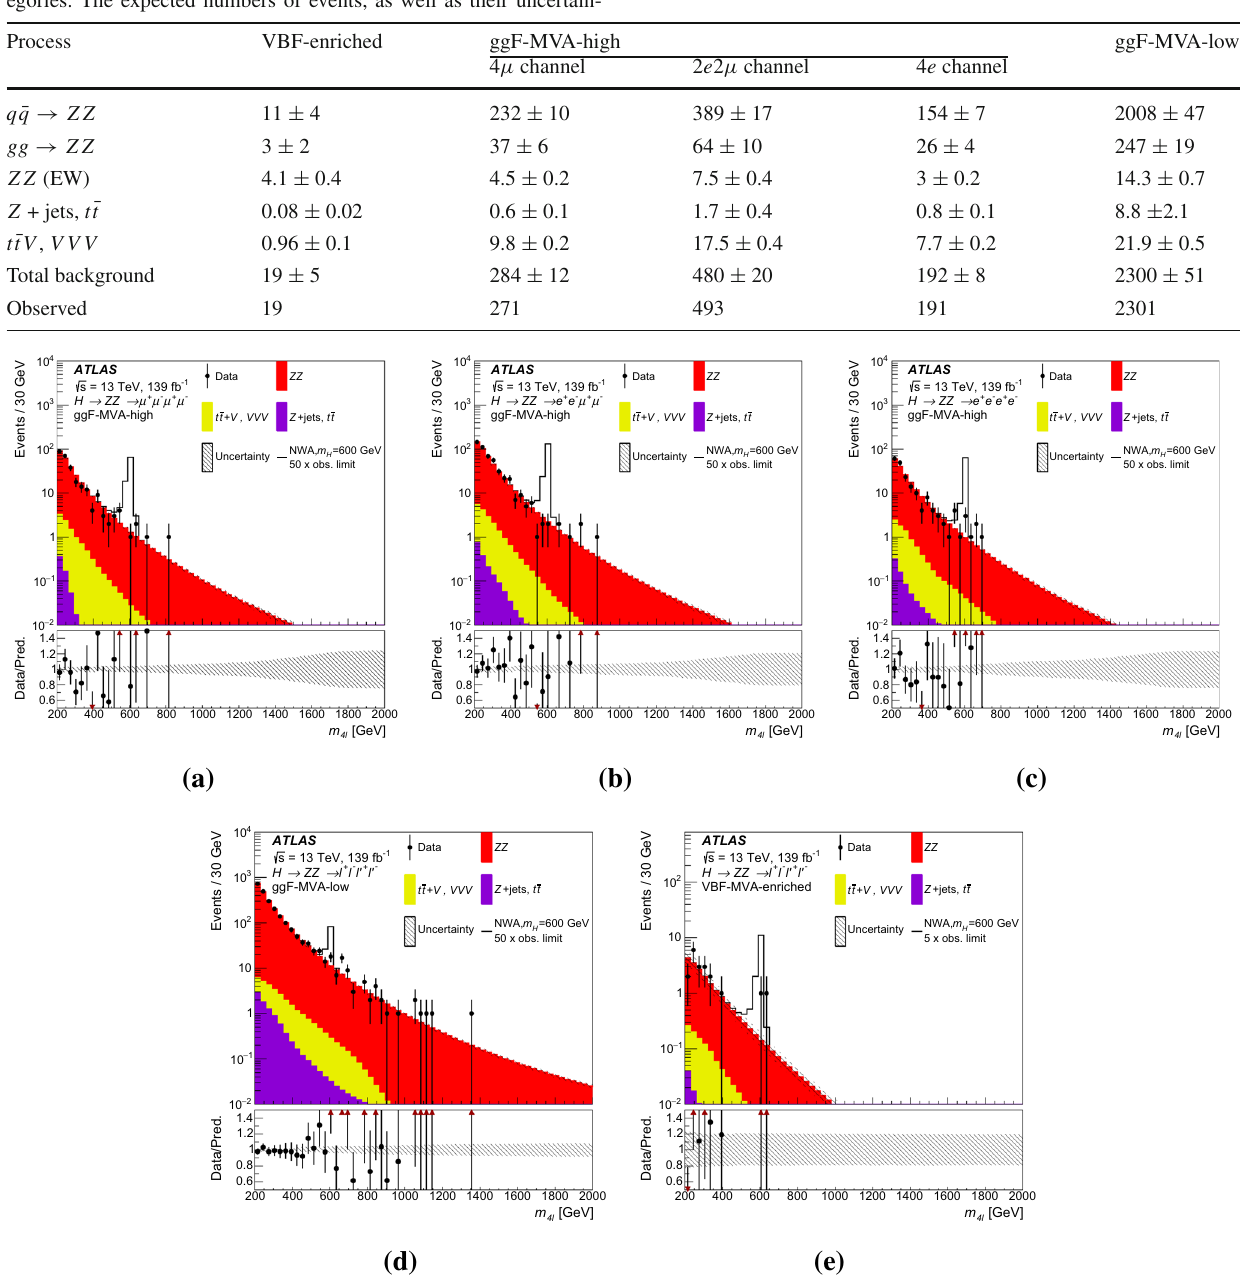
ties, are obtained from a combined likelihood fit to the data under the background-onlyhypothesis.Theuncertaintiesofthe Z Z normalisation factors, presented in Table 2, are also taken into account